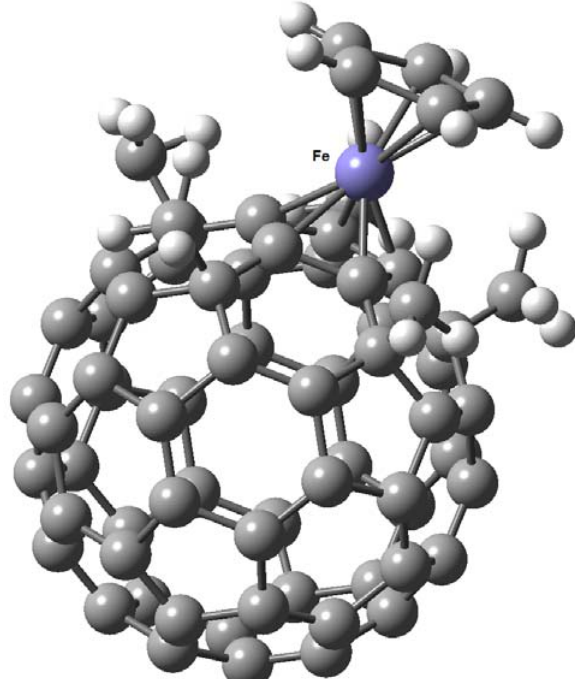
Figure 10. Molecular structure of ferrocene/C diffraction (reproduced from [46] with